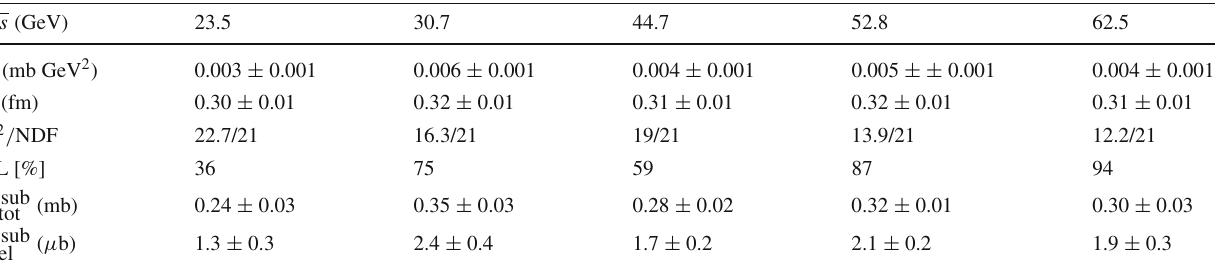
Table 1 Parameters of the Lévy stable source distribution, d σ/ dt = (cid:2) (cid:3) − ( | t | R 2 ) α A exp , characterising the proton substructure at large | t | (1 . 5 ≤ − t ≤ 3 GeV 2 ) corresponding to the secondary diffractive cone